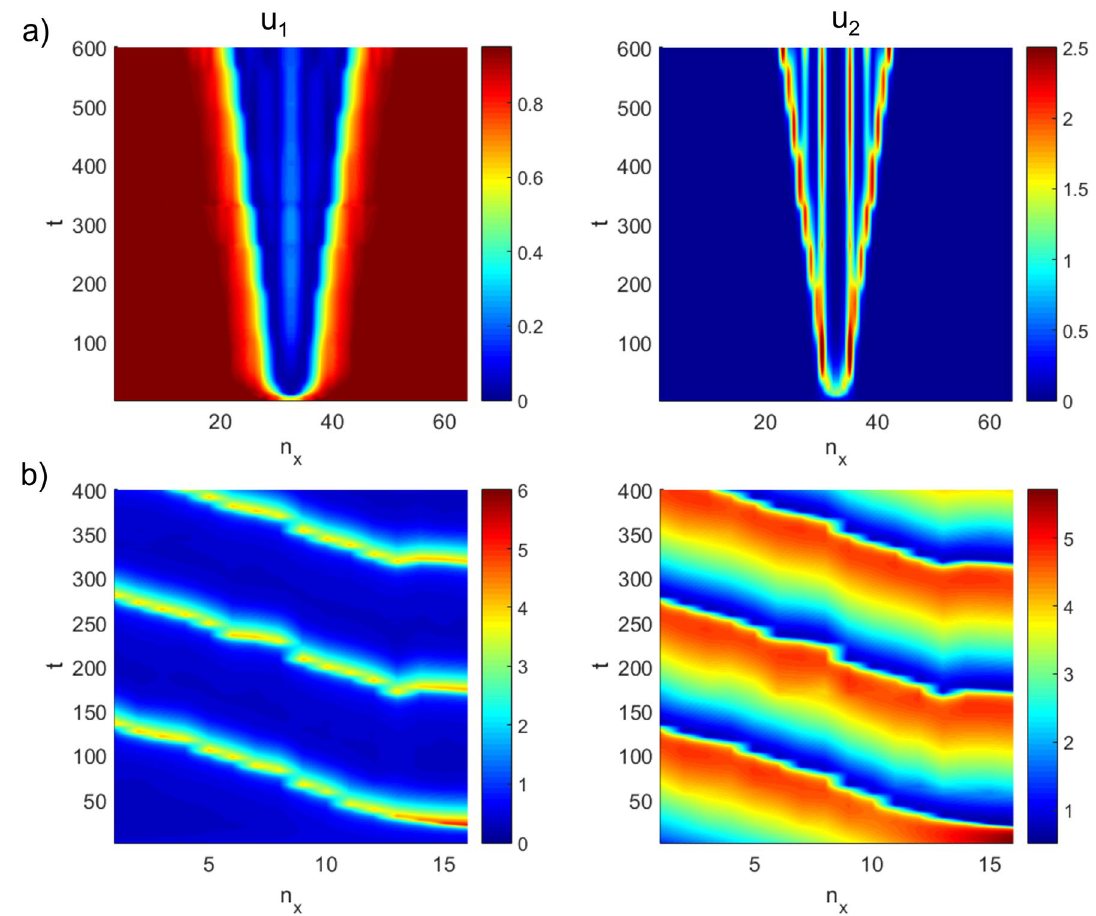
64 grid points up to = 4 , 10 6 T , k 1 10 0.04 , − − = [ ] = 16 grid points up = 4 , 10 4 T , k 1 10 3 , k 2 1 and − − = [ ] = =